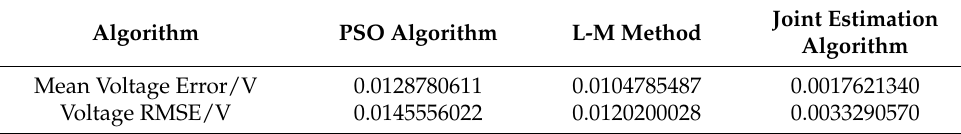
Figure 7. Comparison of LDM output voltage curve based on three types of parameter identification algorithm during the CITY test at 25 °C ambient temperature. ( a ) Voltage curve; ( b )voltage error curve. Table 3. Voltage error statistics based on model parameters from three algorithms.